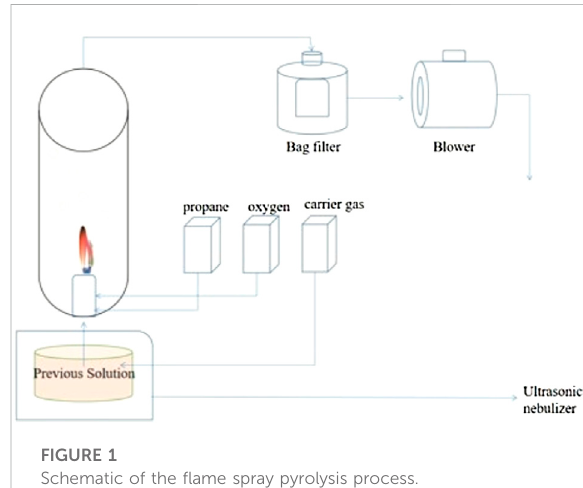
FIGURE 1 Schematic of the fl ame spray pyrolysis